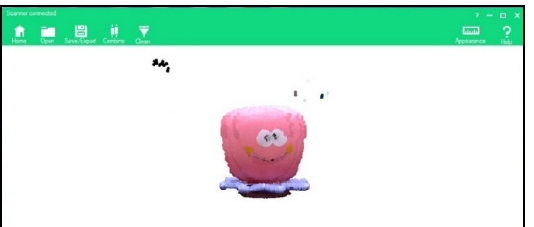
Fig. 7. Noise Points in Dome Case